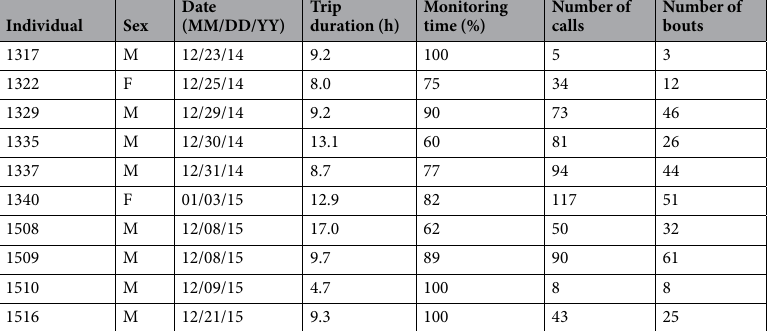
Table 1. Recording time and the number of recorded offshore calls of the individuals used for analysis. Monitoring time was calculated by the proportion of trip duration recorded by camera to total trip duration recorded by